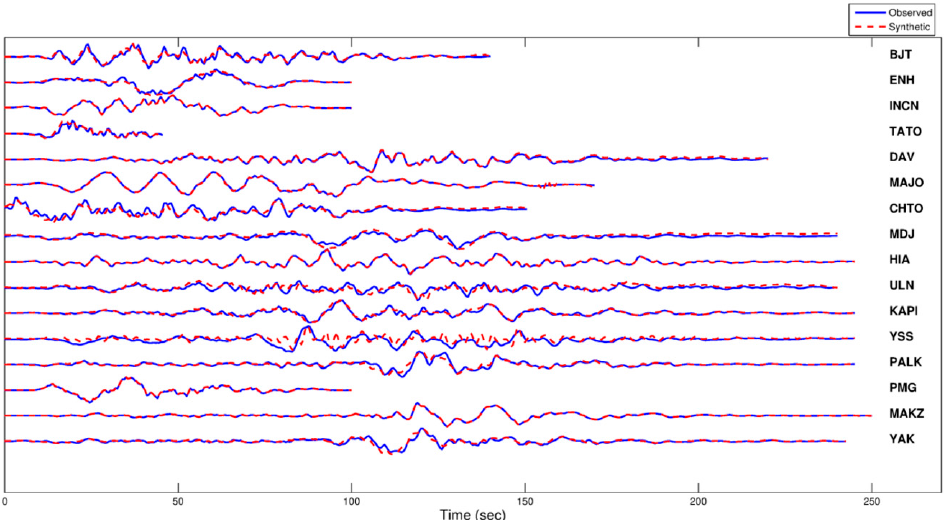
Figure 2. Comparisons of the observed S-wave waveforms (blue line) and synthetic waveforms (dashed line) for the Meinong earthquake. The synthetic waveforms are the convolutions of the derived ASTFs obtained using HHD, with Green’s functions extracted from the waveforms.